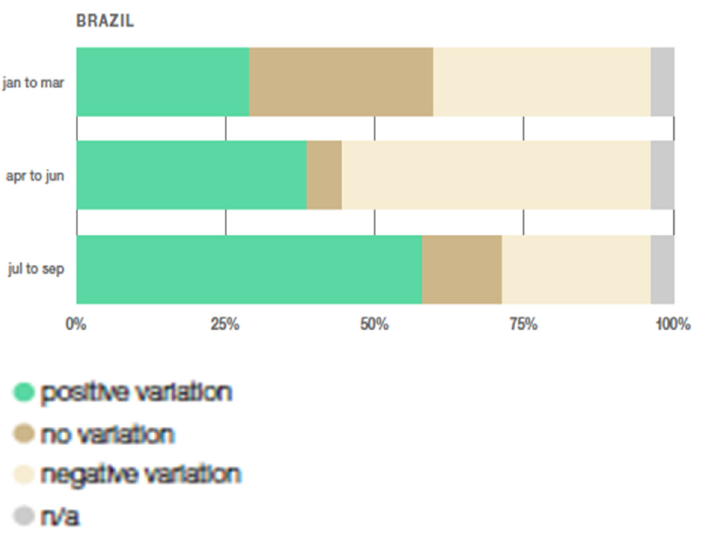
Figure 7. The variation in sales volume per quarter in 2020 (regarding the sales volume registered in 2019). Data source: Esmanhotto and Fialho (2020, p. 13), used with permission.